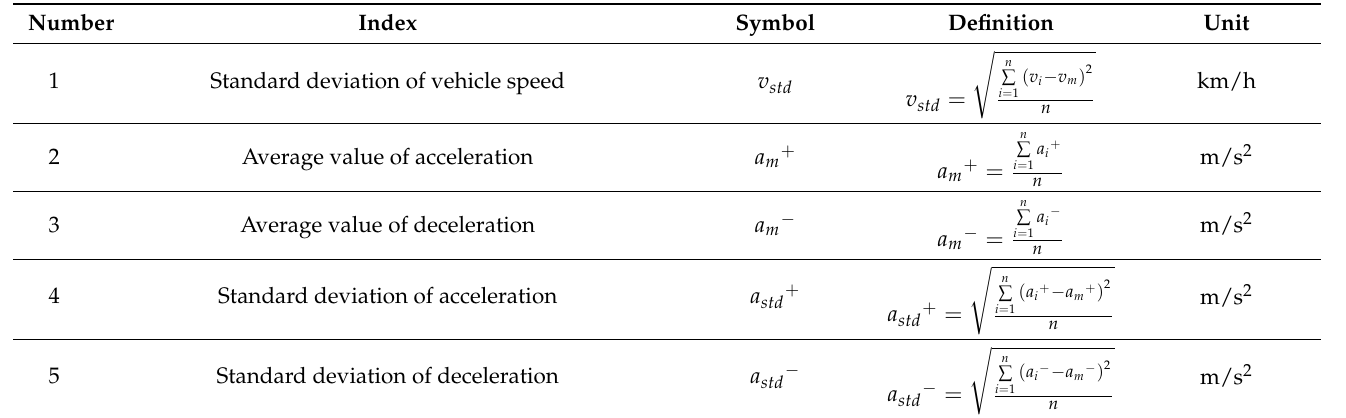
Table 2. The indexes used to evaluate the driving behaviour.